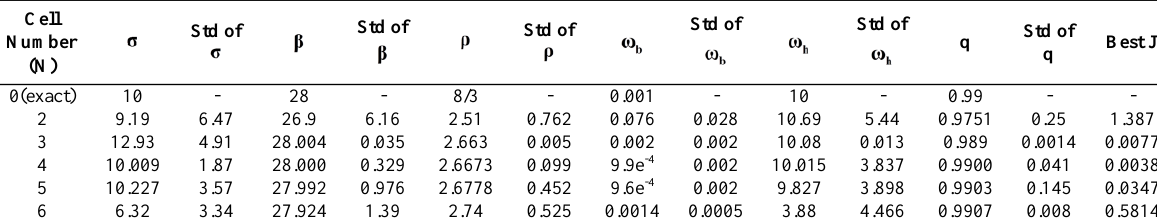
Table 2. Results obtained by PSO method for parameter estimation of approximated fractional-order Lorenz system with 2, 3, 4, 5, and 6 cells.